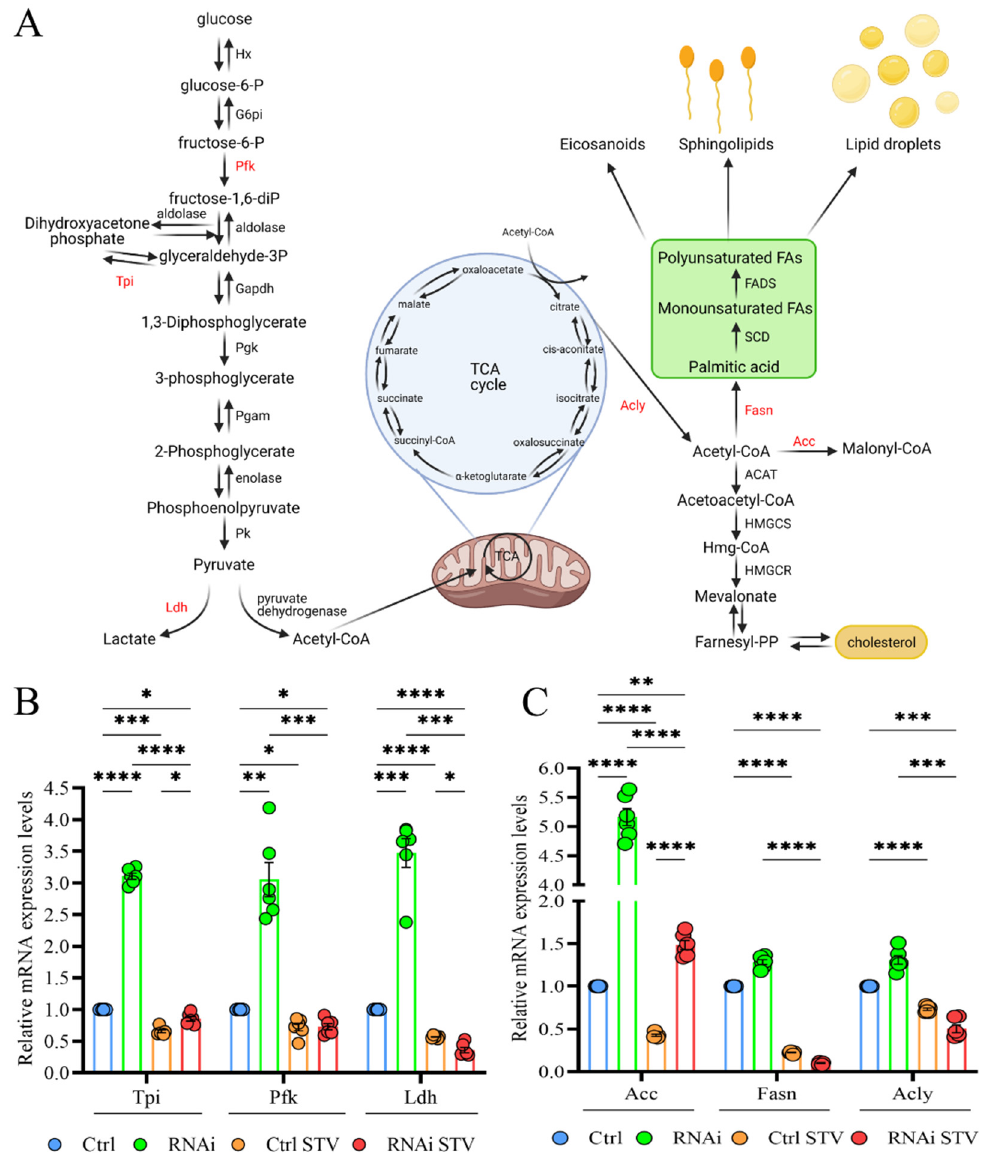
Figure 8. Downregulation of D-idua results in dysregulated glycolysis and lipogenesis. ( A ) Schematic representation of the crosstalk between glycolysis (on the left) and lipogenesis (on the right). The genes considered in our analyses are marked in red. (Created with BioRender. Available at: http://www.biorender.com/. accessed on 23 November 2021). ( B ) Relative mRNA expression levels of genes involved in glycolysis. ( C ) Relative mRNA expression levels of genes involved in lipogenesis. Data are the results of three different larvae extracts, each of them analyzed twice, in triplicate. All data are presented as means ± SEM. Asterisks indicate a statistically significant difference (two-way ANOVA with Tukey’s post hoc test. * p < 0.05; ** p < 0.01; *** p < 0.001; **** p < 0.0001). Genotypes of samples: Ctrl = Tubulin-Gal4/+; RNAi = Tubulin-Gal4/UAS D-idua RNAi3 . STV indicates a starvation of 4 h.